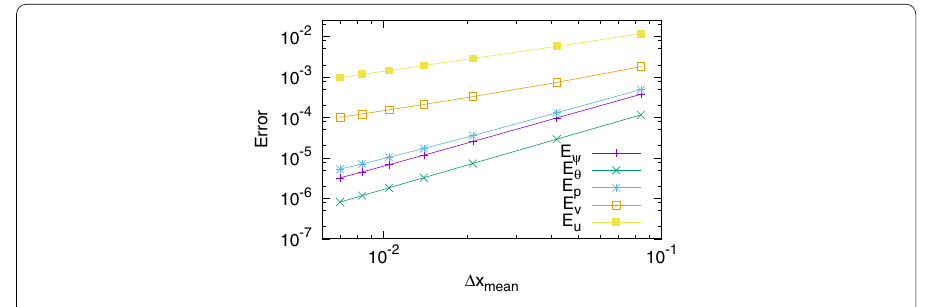
Fig. 32 Couette flow: Relative error on vorticity ψ , temperature θ , flux v and velocity u , and absolute error E d on dynamic pressure p